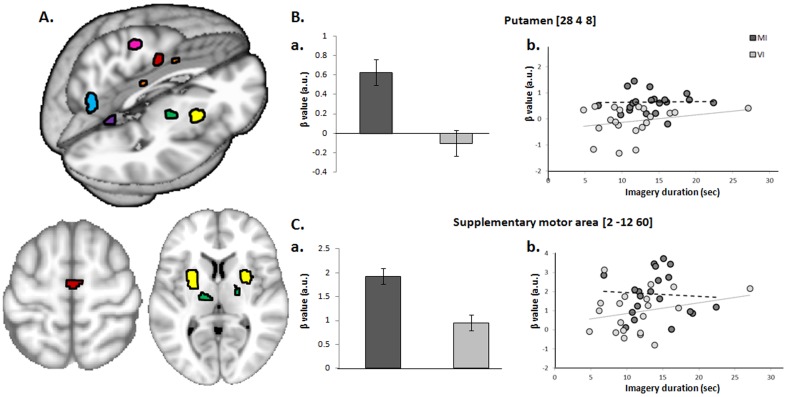
Brain regions activated during motor imagery of dynamic balance.A. Cerebral activity during motor imagery of balance. Statistical parametric map (SPM) of increased activity in the supplementary motor area (red), the dorsal premotor cortex (pink), the middle cingulate cortex (orange), the superior parietal lobule (cyan), the thalamus (green), the putamen (yellow) and the cerebellum (purple), during MI compared to VI [corrected for multiple comparisons (p<0.05) using family wise error (FWE)], superimposed on a 3D rendered brain (upper part) and on axial sections (lower part). B. Putamen activity; a. β values as a function of Task; b. Relationship between behavioral (imagery durations) and neural (β values) changes as a function of Task. Subject-by-subject variance in imagery durations was not correlated with the neural Task-related effects for both the MI (putamen: r = 0.025, p = 0.917) and VI tasks (putamen: r = 0.248, p = 0.291). C. Supplementary motor area activity; a. β values as a function of Task; b. Relationship between behavioral (imagery durations) and neural (β values) changes as a function of Task. Subject-by-subject variance in imagery durations was not correlated with the neural Task-related effects for both the MI (SMA: r = -0.062, p = 0.793) and VI tasks (SMA: r = 0.254, p = 0.279).